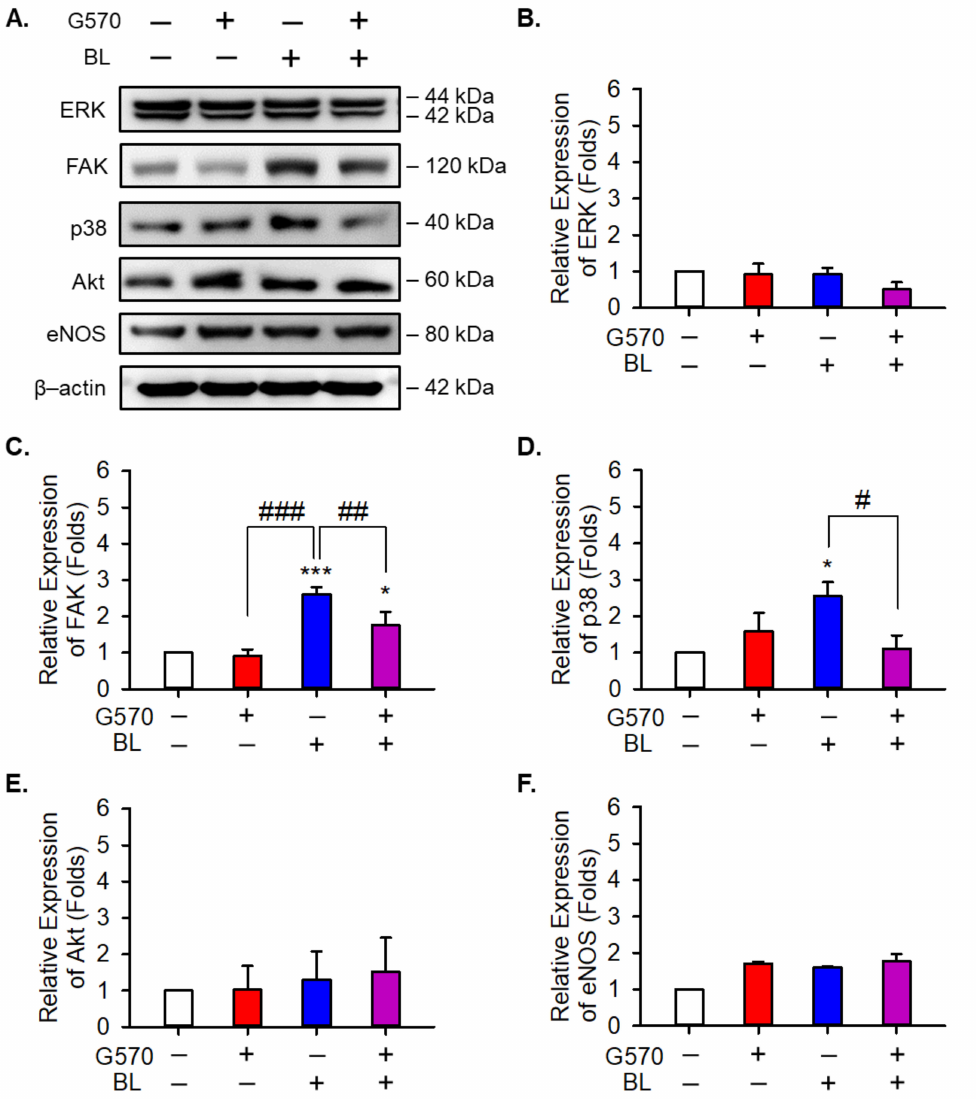
Figure 5. Expression of VEGFA-related proteins in BL-exposed ARPE-19 cells. The cells were seeded in a 6 cm dish. Each group was exposed to 150 lux BL and treated with 0.5 µ M G570. After 24 h, the cells were collected, and total protein was isolated for the western blot assay. ( A ) Western blot of VEGFA-related proteins in ARPE-19 cells. Densitometric analysis of ( A ) was performed to obtain quantitative values for the expression levels of ( B ) ERK, ( C ) FAK, ( D ) p38, ( E ) Akt, and ( F ) eNOS in various treatment groups. Data are expressed as the mean ± S.D. and were obtained in triplicates. Significance was estimated compared to the control, where p * ≤ 0.05, p *** ≤ 0.001; p # ≤ 0.05; p ## ≤ 0.01, and p ### ≤